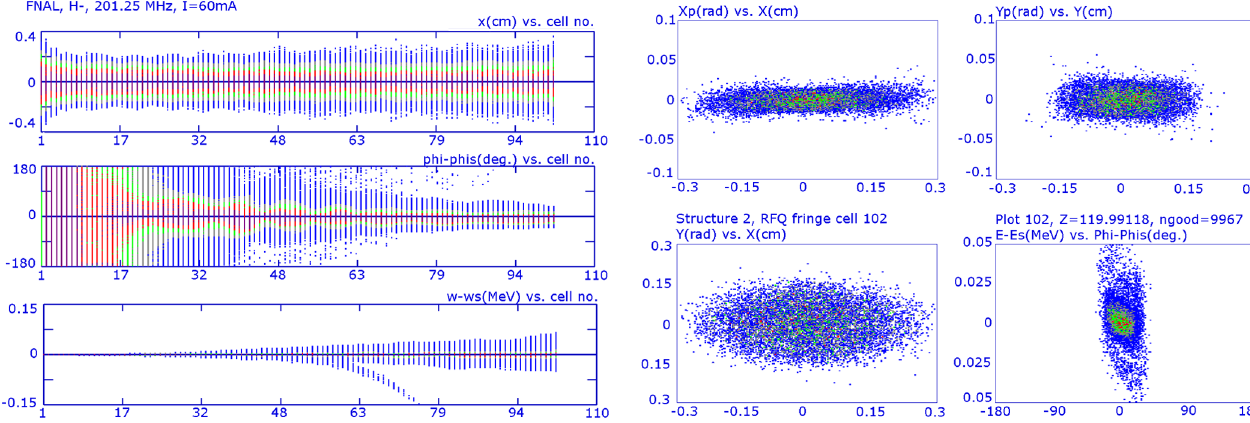
FIG. 2. Results of Parmteq M design. The calculated transmission is 98% with a transverse output rms emittance of 0 . 37 π mm mrad for x and 0 . 35 π mm mrad for y and an unnormalized longitudinal emittance of 0.14 MeV deg. In the right graphs the spatial distribution, the phase, and the energy evolution along the RFQ are pictured next to the output distributions in the left graphs.